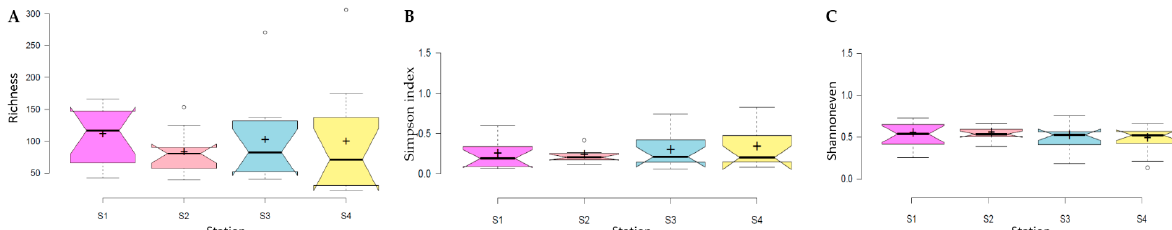
Figure 3. Box plots showing ( A ) richness, ( B ) diversity (Simpson index), and ( C ) shannoneven of ciliate communities in four sampling stations. Thickest line and plus sign inside each box represent the median and mean of distribution; bottom and top borders of boxes correspond to first and third quartiles; and whiskers extend to the minimal and maximal values. Notches represent 95% confidence interval for each median. The hollow dots denote outliers.